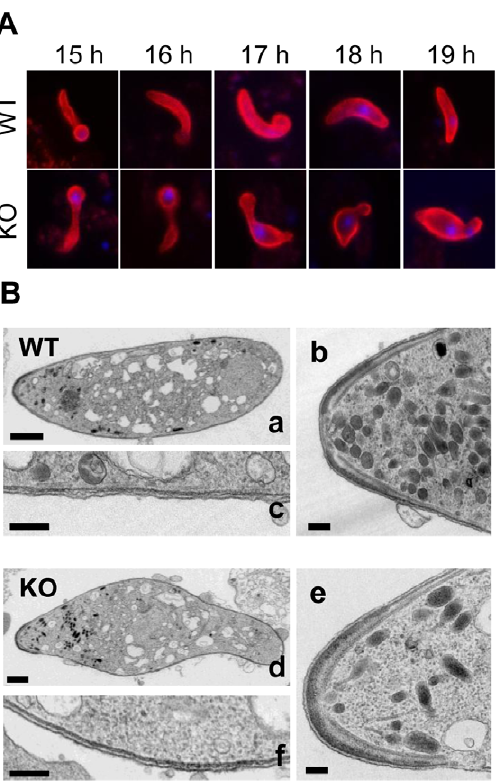
Figure 3. Ookinete morphology of IMC1h-KO. A. Comparative developmental time course from 15 h to 19 h post-fertilisation of WT ookinetes (upper panels) and IMC1h-KO ookinetes (lower panels). Developing ookinetes have been stained for P28 (red) and the nucleus has been counterstained with DAPI (blue). At 16 h, WT ookinetes have transformed to an elongated cell but IMC1h-KO ookinetes failed to reach this even shape. Instead they formed a pronounced bottleneck between the zygote body and the outgrowing protrusion resulting in a widening at the anterior end. B. Longitudinal TEM section of WT (upper panel) and IMC1h-KO (lower panel) ookinetes with anterior end to the left. Low magnification views (a and d) show the abnormal shape of IMC1h-KO (scale bar=1 m m). No obvious alterations at the apical end (b and e) and the pellicle (c and f) could be observed in higher magnification views (scale bar=200 nm).